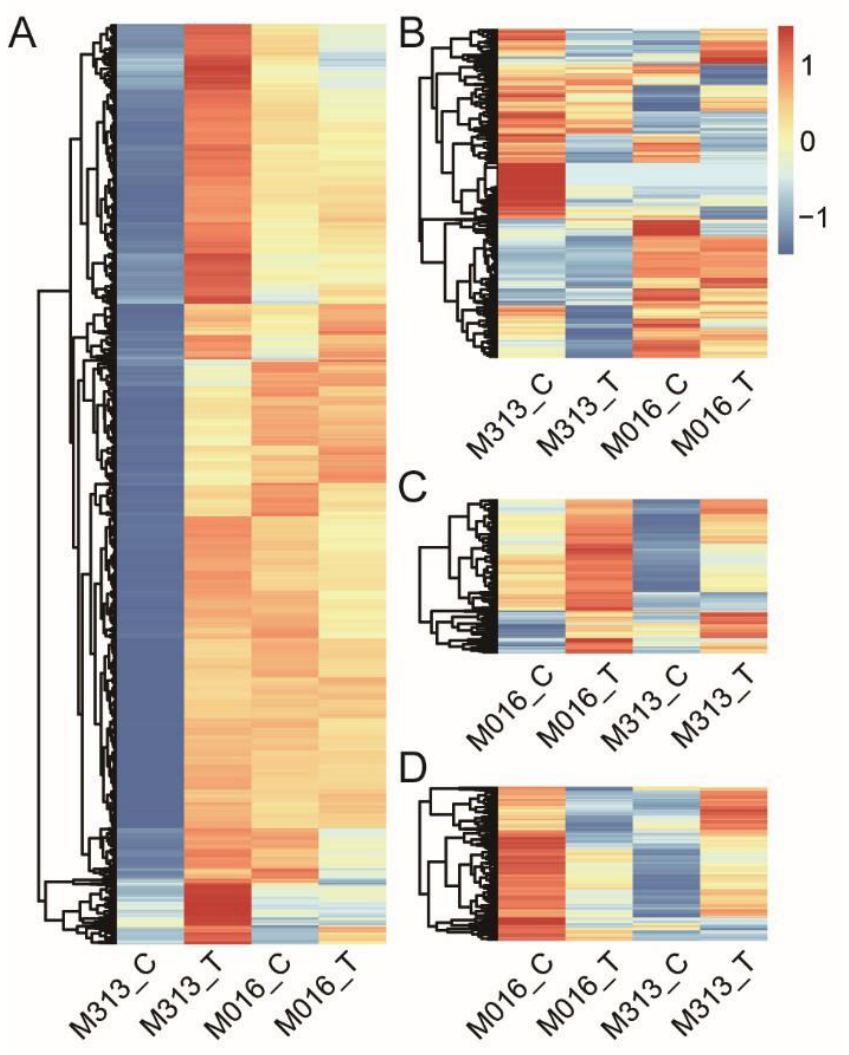
Figure 2. Heatmap of DEGs with orthologous transcripts in the leaves of diploid and tetraploid M. lutarioriparius . ( A ) Heat map of up-regulated transcripts with orthologs in leaves of M313. ( B ) Heatmap of down-regulated transcripts with orthologs in leaves of M313. ( C ) Heatmap of up-regulated transcripts with orthologs in leaves of M016. ( D ) Heat map of down-regulated transcripts with orthologs in leaves of M016. Red and blue colors represent up-regulated and down-regulated transcripts, respectively. The darker the color is, the greater the difference of genes expression level is.